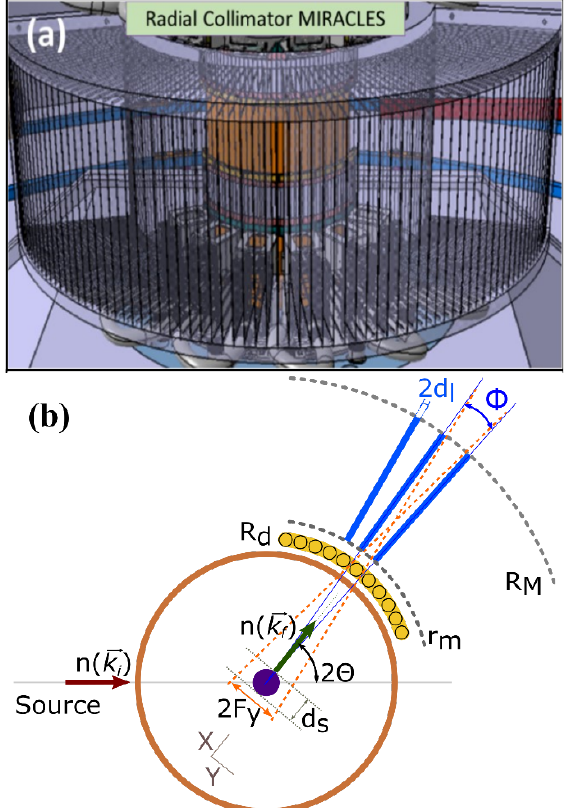
Fig. 1. (a) 3D preliminary model of the MIRACLES radial collimator; (b) Geometry of the radial collimator calculations.